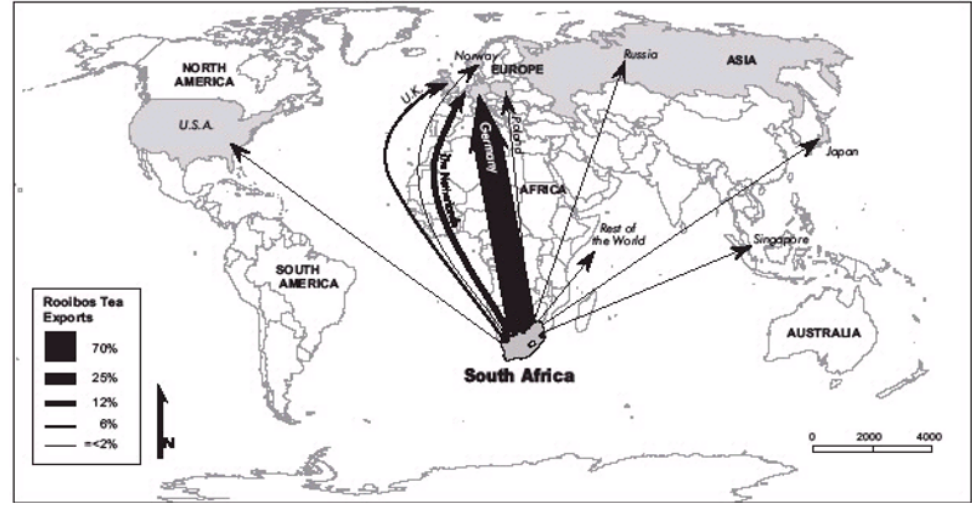
Figure 1. Rooibos tea export to different international markets adapted from Olivier, J. 2008. Tea is one of the world’s most consumed beverages, alongside cocoa and coffee [2].